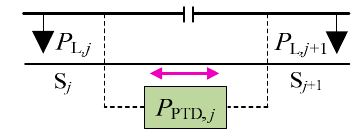
Figure 9. Power quality improvement by EPTD.